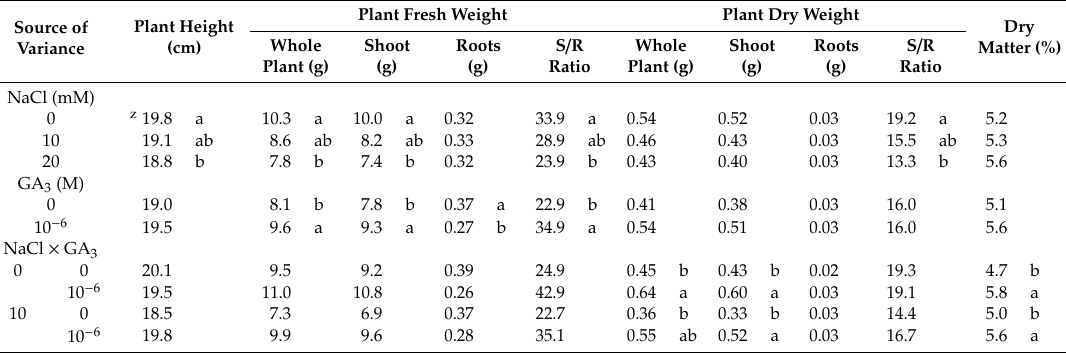
Table 5. Morphological parameters of rocket plants grown in nutrient solutions containing di ff erent levels of NaCl and GA 3